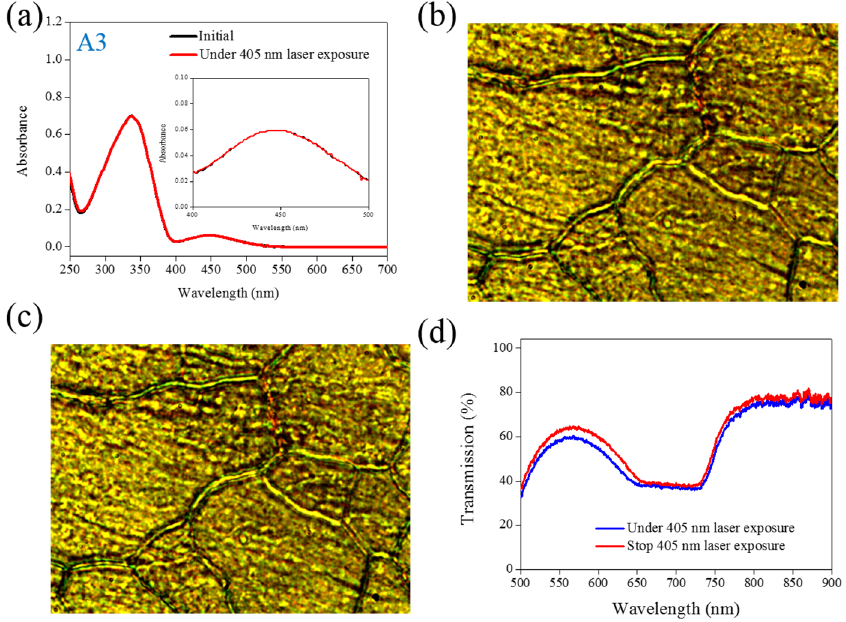
Figure 3. ( a ) Absorption spectral response of A3 of 1 ˆ 10 ´ 5 M in the THF solution before and under 405-nm laser irradiation; ( b , c ) Typical POM images (picture area: 270 µ m ˆ 320 µ m) of A3-doped CLC (15 wt% A3, 20 wt% ZLI811, and 65 wt% MDA3461) under ( b ) and stop ( c ) 405-nm laser exposure; ( d ) The transmission spectra of A3-doped CLC under different conditions of laser exposure.